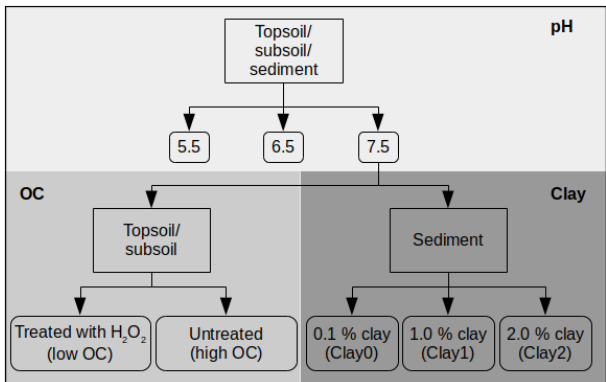
Figure 1. Experimental design for the different treatments of the batch